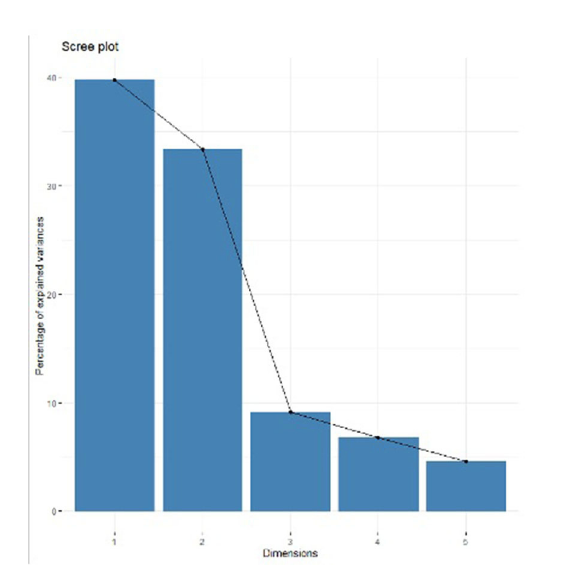
FIGURE2 Percentages of inertia explained by each factorial analysis of mixed data dimension.